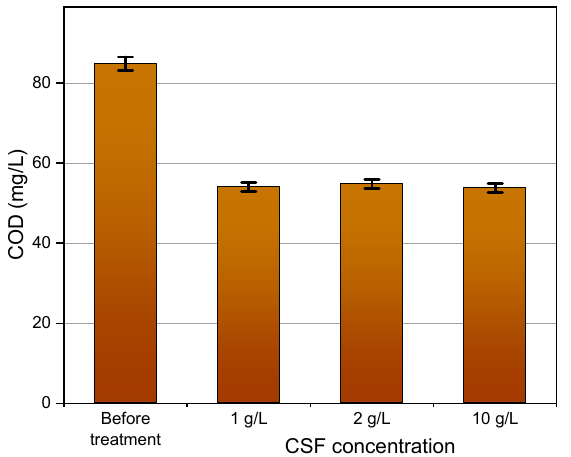
Figure 6. Chemical oxygen demand (COD) in the concentrated wastewater effluent before and after treatment with different amounts of CSF for 5 h.